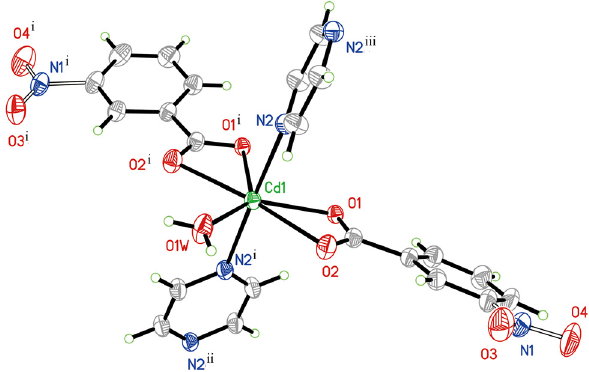
Table  : Data collection and handling. Crystal: